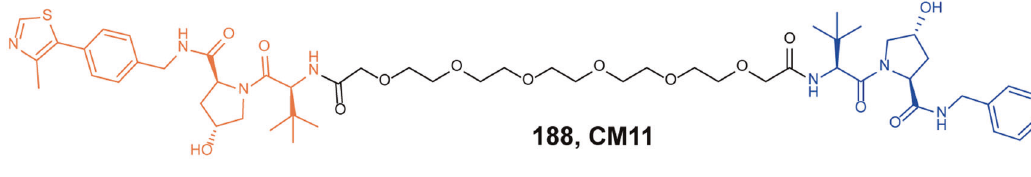
Fig. 51 The representative PROTAC targeting VHL